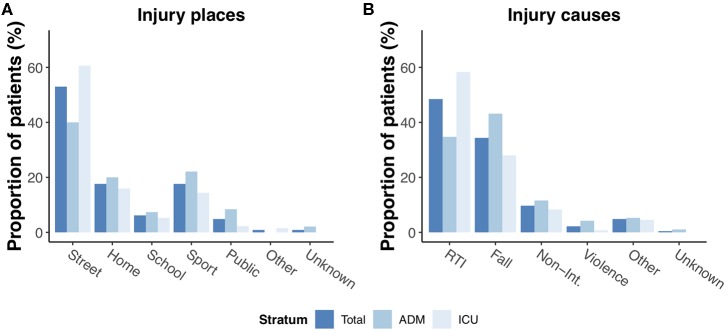
Injury places (A) and causes (B) of pediatric TBI in the entire core dataset and admission/ICU patients. RTI: Road-traffic incident; Non-Int.: Other non-intentional injury.